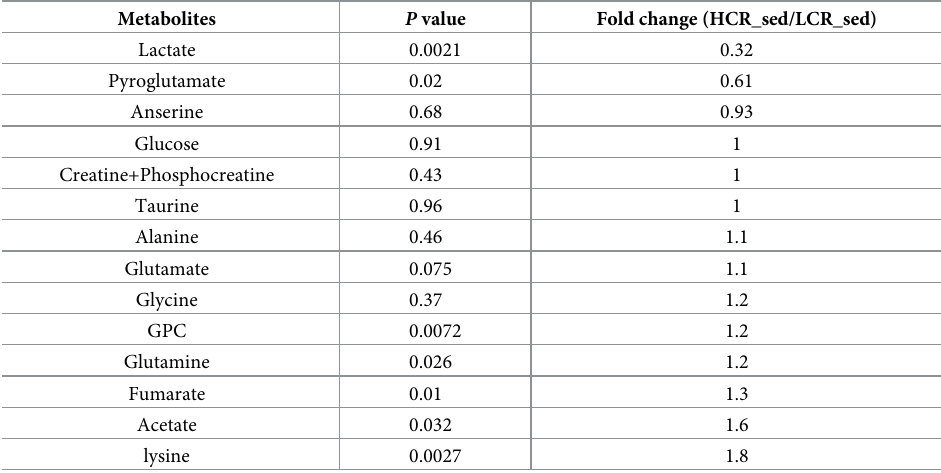
Table 3. Univariate analysis between 18 months LCR sed and 18 months HCR